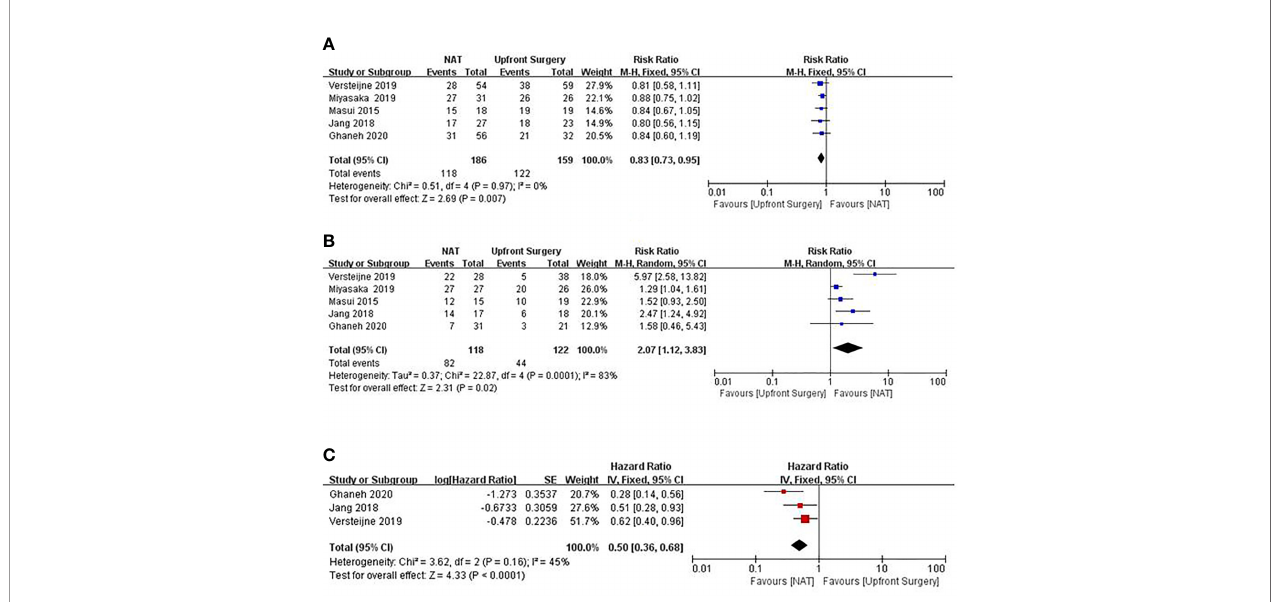
FIGURE 1 | Forest plots showing risk ratios of resection rate (A) , R0 resection rate (B) , and HR of overall survival (C) in